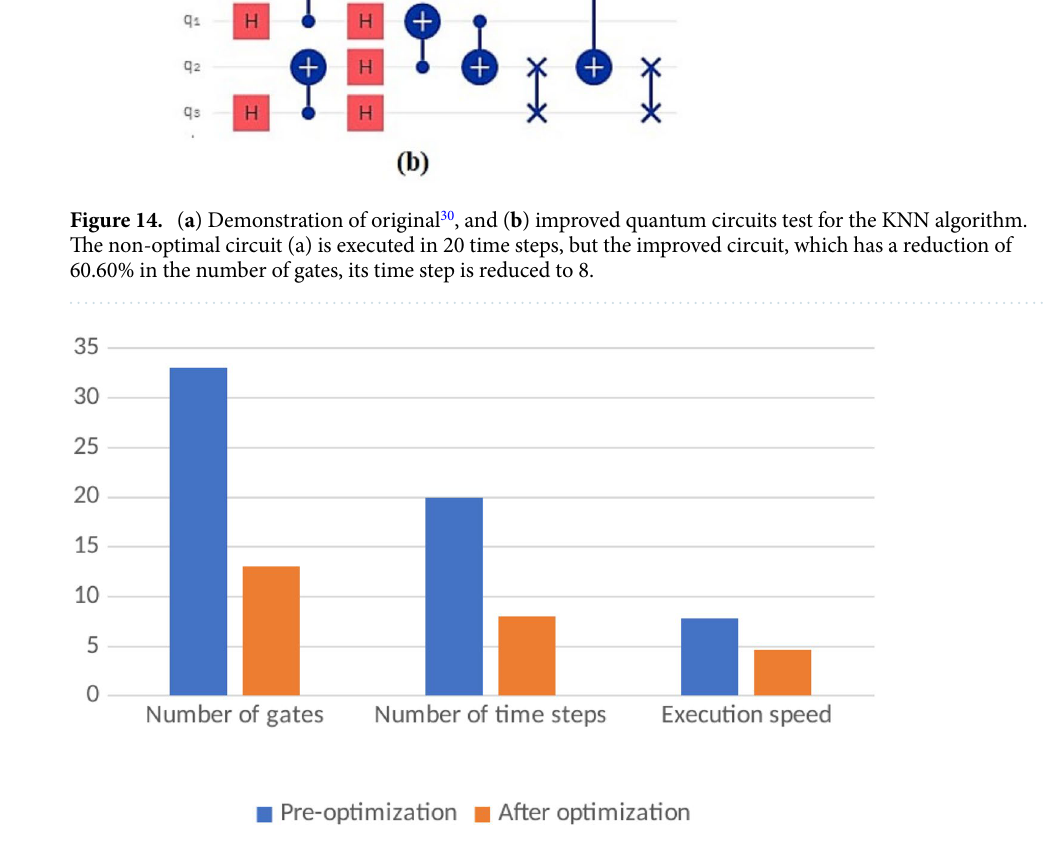
Figure 15. Comparison between optimized and non-optimized quantum circuits test for the KNN